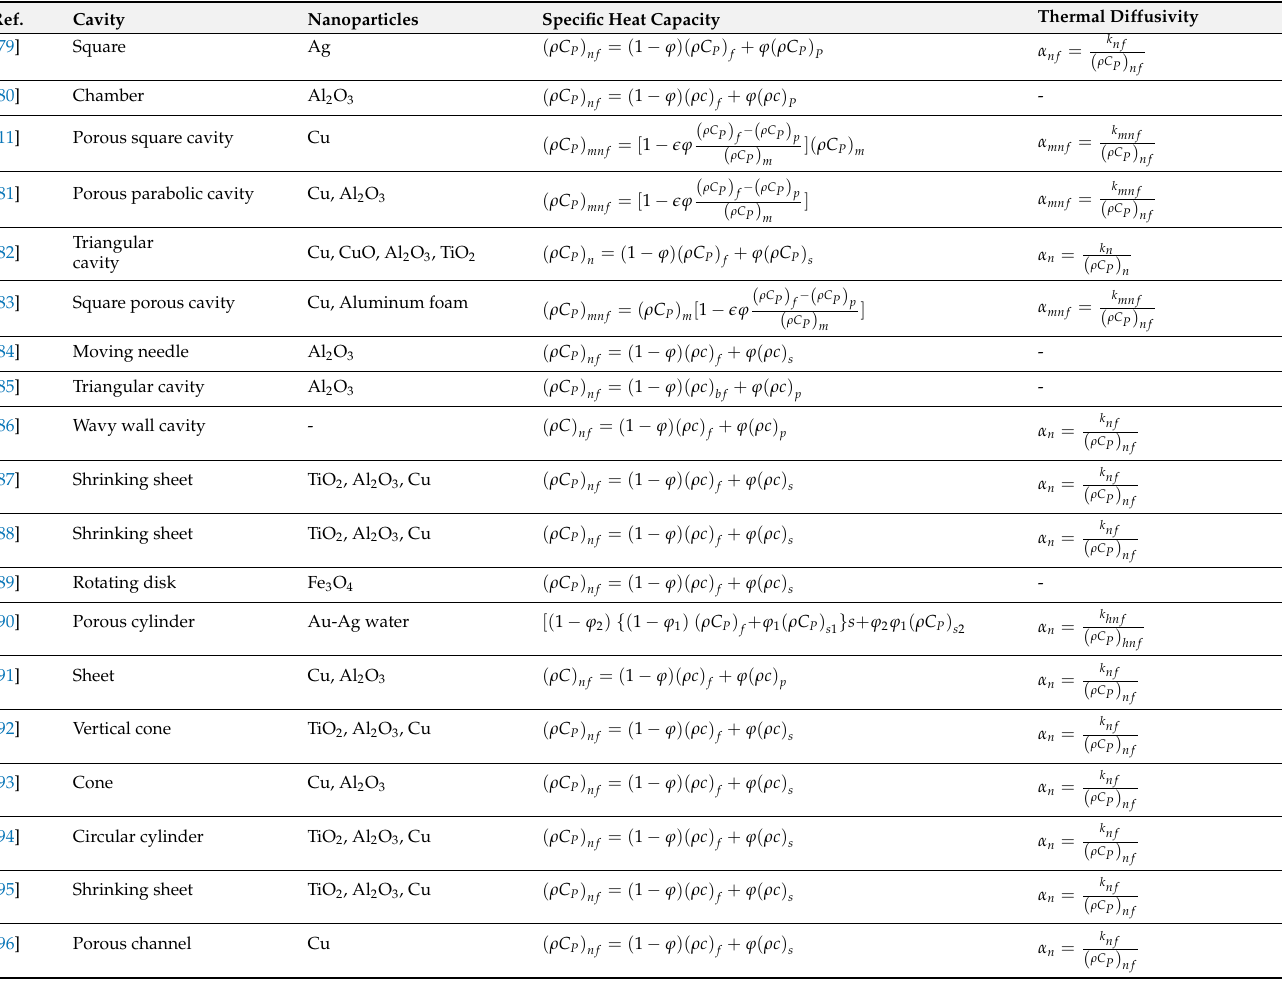
Table 4. Specific heat capacity and thermal diffusivity used by researchers using Tiwari and Das model in different